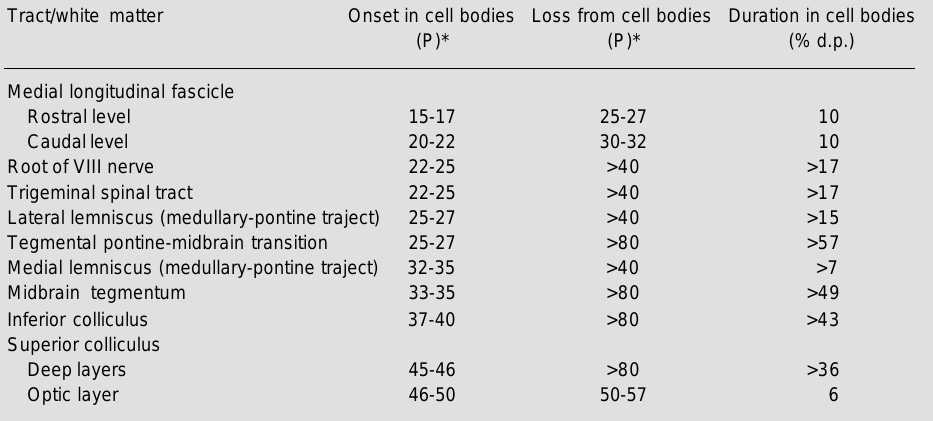
Table 1 - CNPase expression in the opossum brain stem. *The first postnatal (P) day of the range referring to onset in (loss from) cell bodies indicates that CNPase immunoreactivity was still not detected (still detected). % d.p.: Percent of developmental period